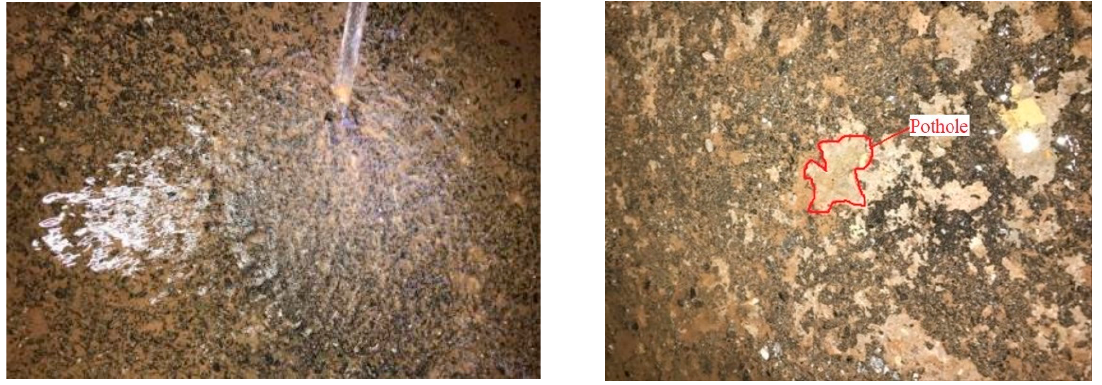
Figure 16. Erosion test results.